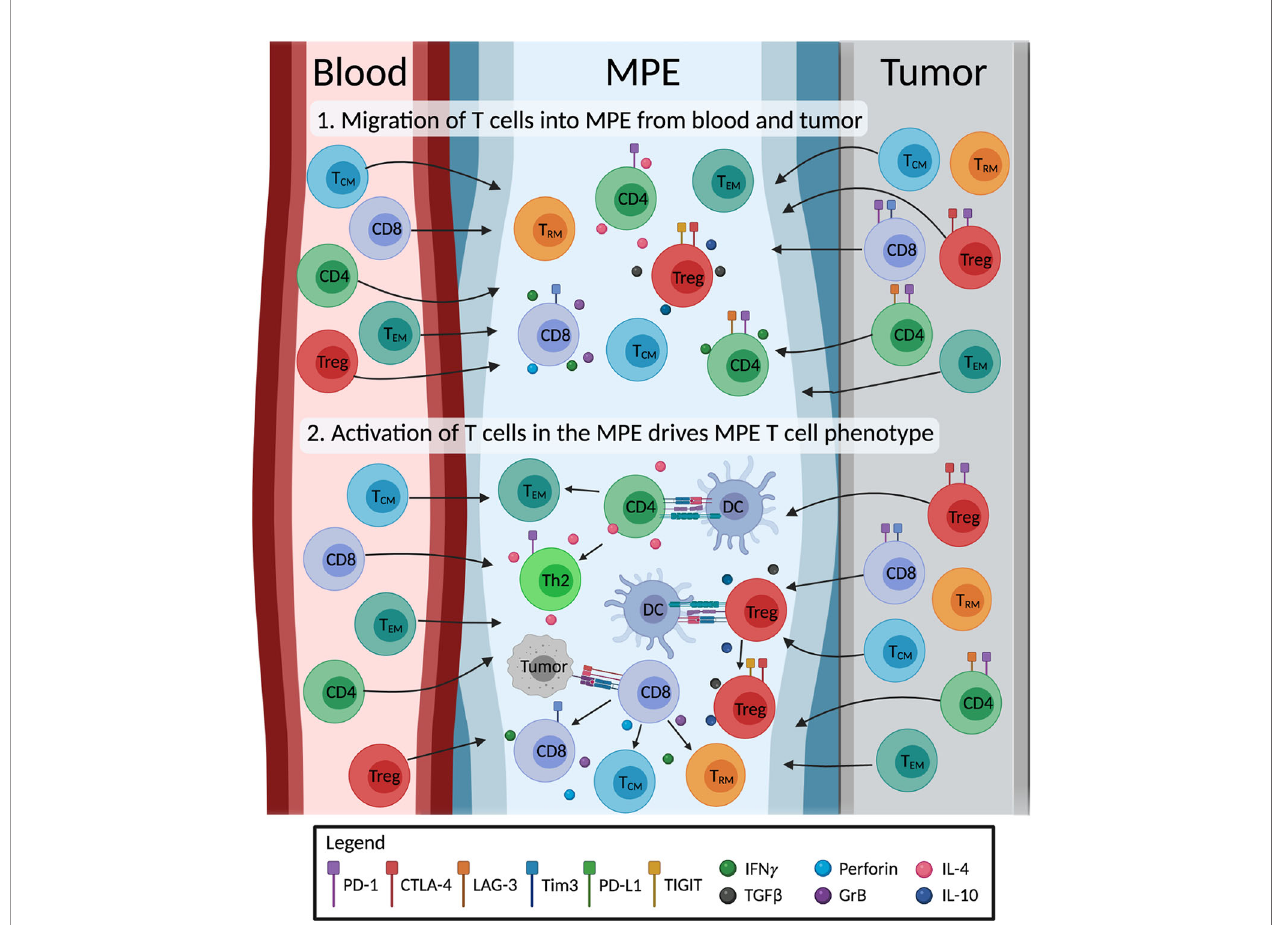
FIGURE 2 | Illustration of the proposed origin and development of MPE T cells. The impact of the MPE environment on T cell differentiation is unclear. We hypothesize that 1) MPE acts as a sink, containing a mix of T cells originally from the blood and the tumor site. 2) MPE environment including cytokines and other cells (e.g. tumor cells, dendritic cells; DC) drive changes in phenotype of MPE T cells. MPE T cells differentiate into effector subtypes, producing immunostimulatory (IFN g , perforin, granzyme B; GrB, IL-4) or immunosuppressive (TGF- b , IL-10) cytokines; exhausted T cells expressing inhibitory receptors; and differentiate into memory T cells (i.e. effector (T EM ), central (T CM ) and tissue resident (T RM ) memory T cells). Figure created with BioRender.com.